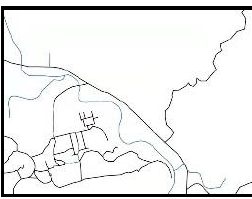
Figure 4 . Comparison diagram of test results